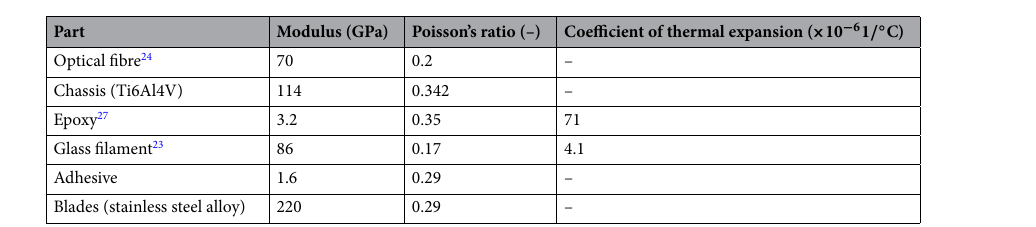
Table 1. The values of the material constants used in the FE modelling.